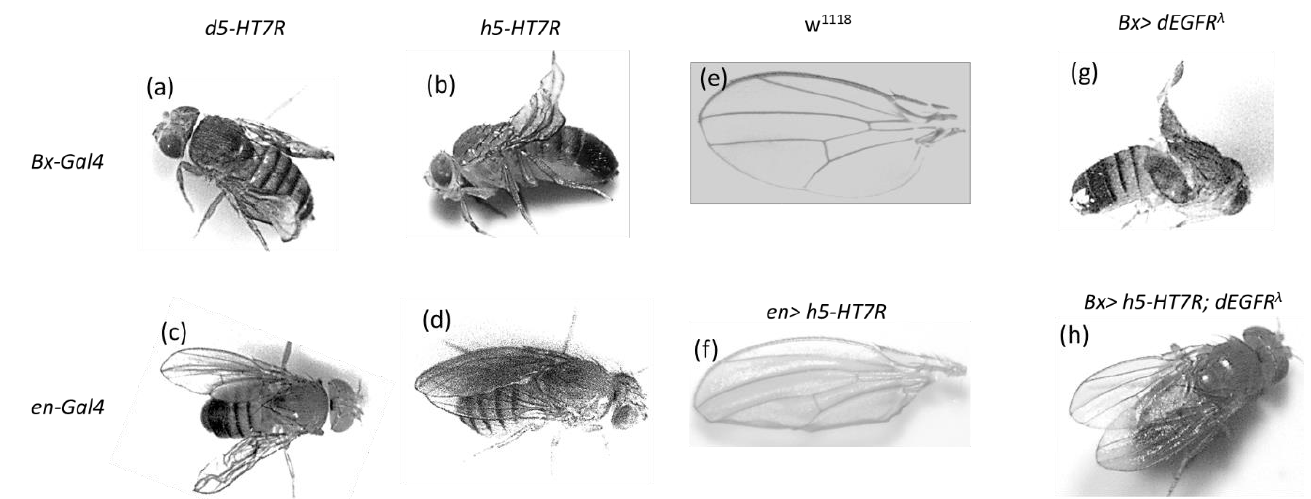
Figure 2. Drosophila or human 5-HT 7 receptor expression affects wing patterning. ( a , c ) Expression of the Drosophila d5-HT 7 R, ( b , d ) expression of the human h5-HT 7 R. Expression in the dorsal com- partment (Bx-Gal4) induces “curly” wings ( a , b ). Expression in the posterior compartment (en-Gal4) mimics “rolled” phenotypes ( c , d ). ( e ) Wing from wild-type control (w 1118 ), ( f ) wing from ( d ). Expres- sion of a constitutive form of Drosophila EGFR (dEGFR λ ) alters wing patterning ( g ). Expression of h5-HT 7 R suppresses the phenotype induced by dEGFR λ ( h ).